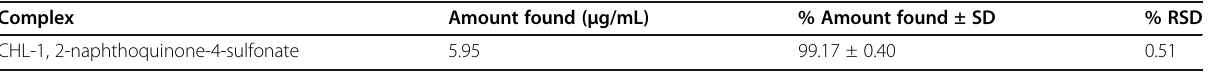
Table 2 Analysis of tablet matrix containing Chlorthalidone (6.25 mg/tablet)